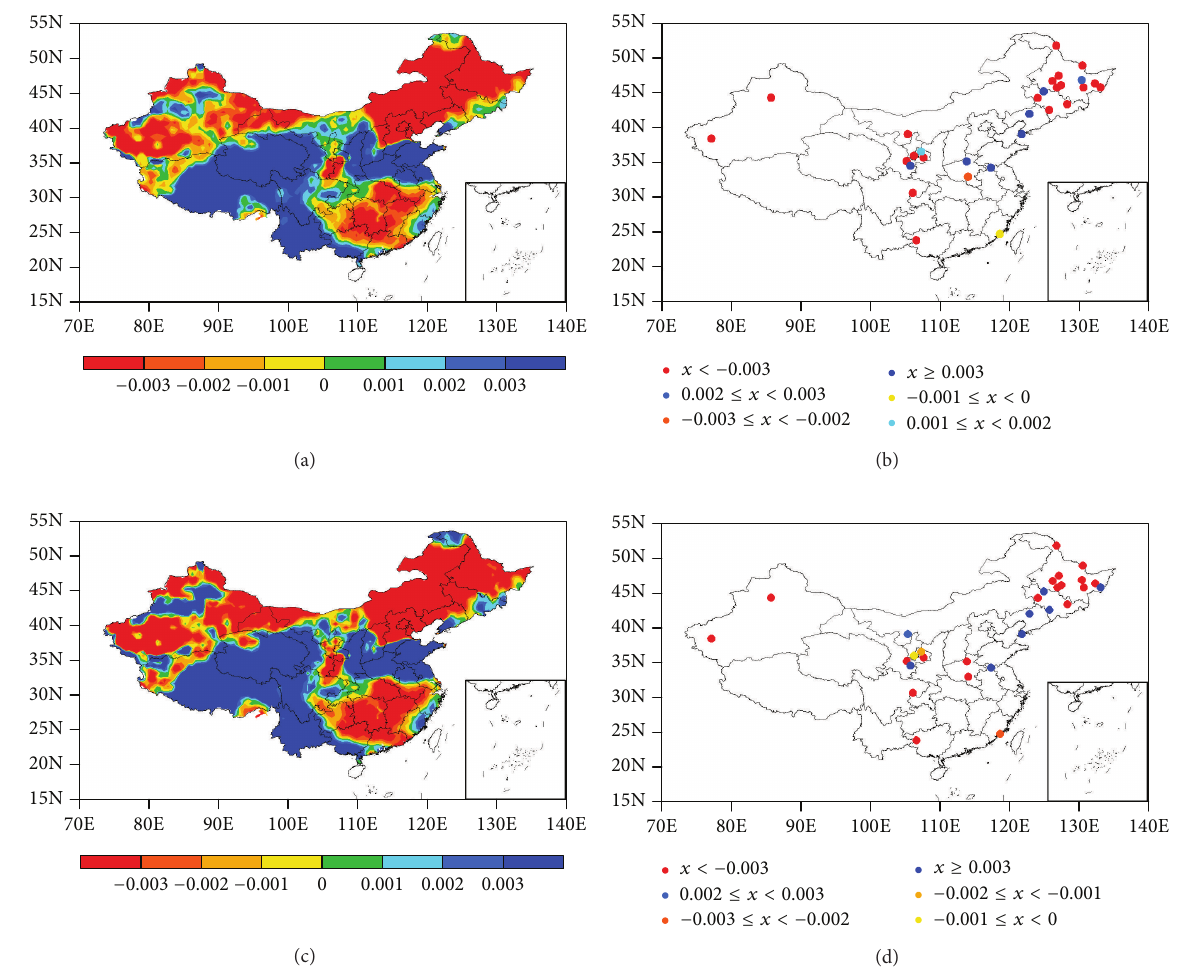
Figure 3: Spatial distribution of variation linear trends of simulated mean and measured SM for April to November of 1981–1999 (unit: (m 3 /m 3 )/10a). (a) CLM4.0 simulated SM (0–9.06 cm); (b) measured SM (0–10cm); (c) CLM4.0 simulated SM (0–49.3 cm); and (d) measured SM (0–50